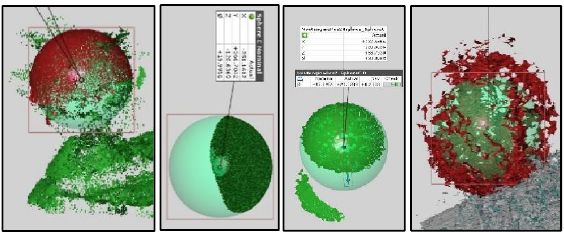
Figure 7. The four images show the sphere fitting.